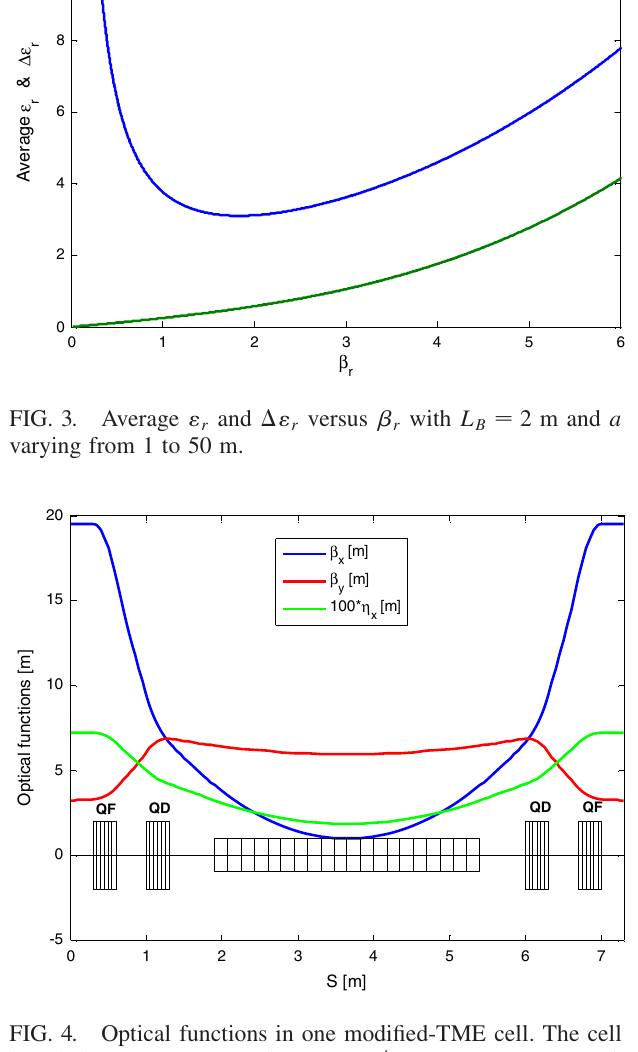
FIG. 4. Optical functions in one modified-TME cell. The cell length is 7.3 m, L B ¼ 3 : 5 m , (cid:3) ¼ (cid:8)= 99 , D r ¼ 4 , (cid:5) r ¼ 2 : 16 , ¼ 3 : 9 , and (cid:6) ¼ 73 : 4 degrees " r x